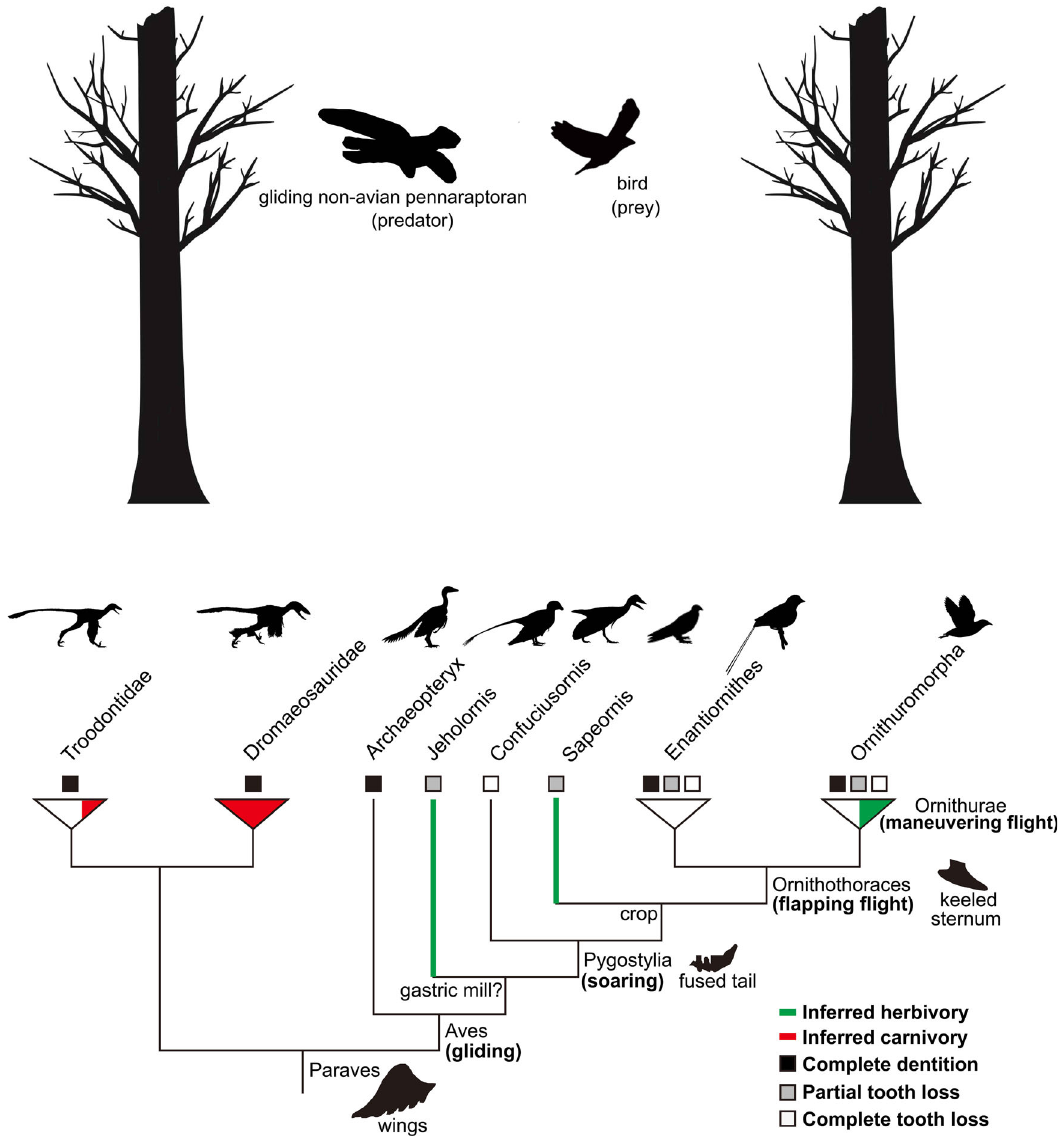
Fig. 3 Schematic representation of the predation hypothesis underlying the origin of birds proposed in this study. The predation of gliding predatory non-avian maniraptorans (pennaraptorans) on ancestral birds in the context of the arboreal theory is shown (please see text for details). Paraves phylogeny with digestive system characteristics (gastric mill, crop, and tooth) and taxonomic de fi nition (e.g., Aves) are based on one previous study 3 . The dietary information follows published studies 3,15,82 . The fl ight-related anatomical features (wings, fused tail, and keeled sternum) along phylogeny follow one published study 146 . The progressive enhancement of fl ight performance from gliding to soaring, fl apping fl ight, and maneuvering fl ight within Aves is based on published literature 5 . Species silhouettes corresponding to each of phylogenetic taxa used are from phylopic.org and are designed by (from left to right) the following: Troodontidae (Scott Hartman), Dromaeosauridae (Scott Hartman, modi fi ed by T. Michael Keesey), Archaeopteryx (Dann Pigdon), Jeholornis (Matt Martyniuk), Confuciusornis (Scott Hartman), Sapeornis (Matt Martyniuk), Enantiornithes (Matt Martyniuk), and Ornithuromorpha (Juan Carlos